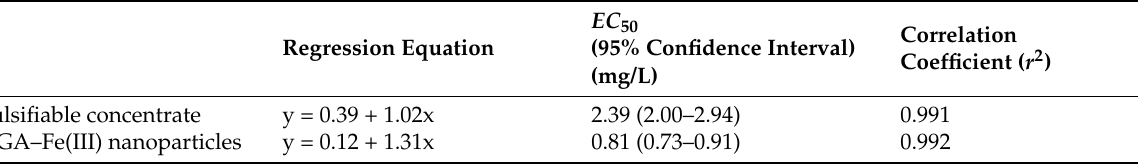
Table 4. Regression equation models obtained from prochloraz emulsifiable concentrate and